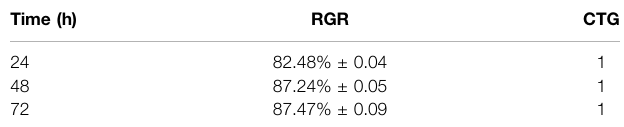
TABLE 1 | The relative growth rates (RGR) and cell toxicity grade (CTG).